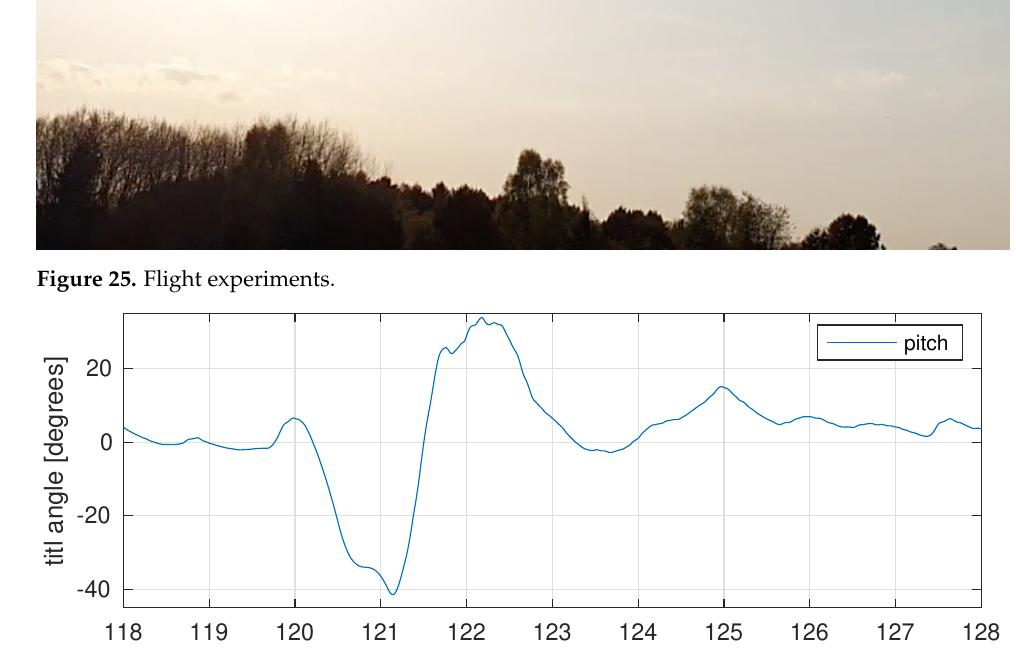
Figure 26. Telemetry log from an in-flight experiment: a sudden pitch down (a dive) after the transition into plane mode because of misplaced CG—eventually rescued thanks to an immediate switch back to quadcopter